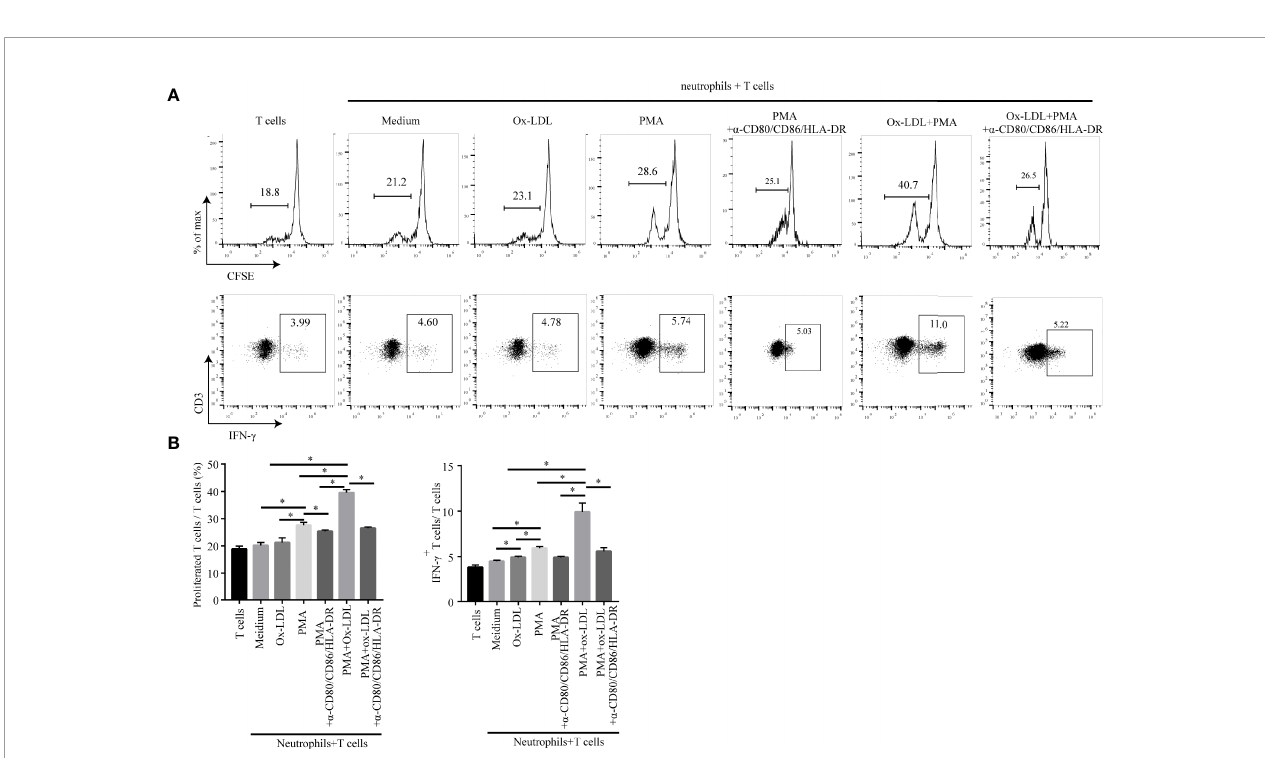
FIGURE 5 | APC-like neutrophils increase T cell proliferation and IFN- g production in vitro . Isolated CFSE-labelled peripheral CD3 + T cells of healthy donors were co- cultured for 5 days with neutrophils treated under different conditions: medium, ox-LDL, PMA, ox-LDL +PMA, with or without blocking antibodies (human HLA-DR/ CD80/CD86 neutralization antibodies). Representative graphs (A) and statistical analysis (B) of T cell proliferation and IFN- g production were shown (n=3). *p <